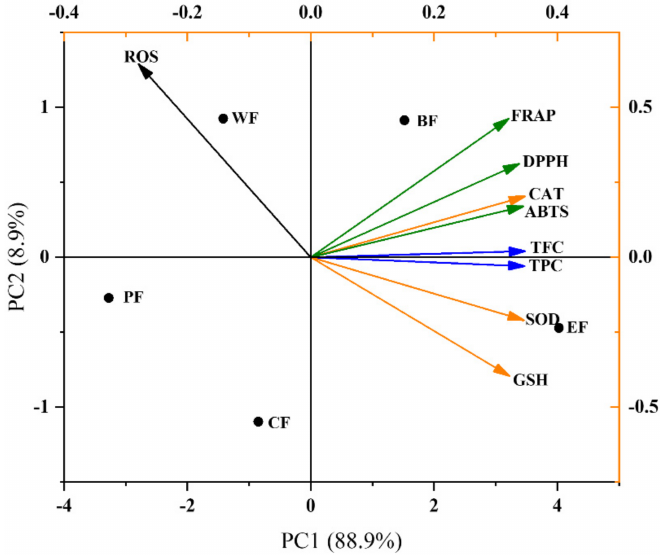
Figure 6. The PCA compositional analysis. Effects of PF, CF, EF, BF, and WF on total phenolics (TPC), total flavonoids (TFC), CAT, GSH, SOD, DPPH, FRAP, ABTS, and ROS. PF, CF, EF, BF, and WF denoted petroleum ether fraction, chloroform fraction, ethyl acetate fraction, n -butanol fraction, and water fraction. CAT, GSH, SOD, DPPH, FRAP, ABTS, and ROS denoted catalase, glutathione, superoxide dismutase, 2,2-Diphenyl-1-picrylhydrazyl, Ferric ion reducing antioxidant power, 2,2’- Azinobis-(3-ethylbenzthiazoline-6-sulphonate), and reactive oxygen